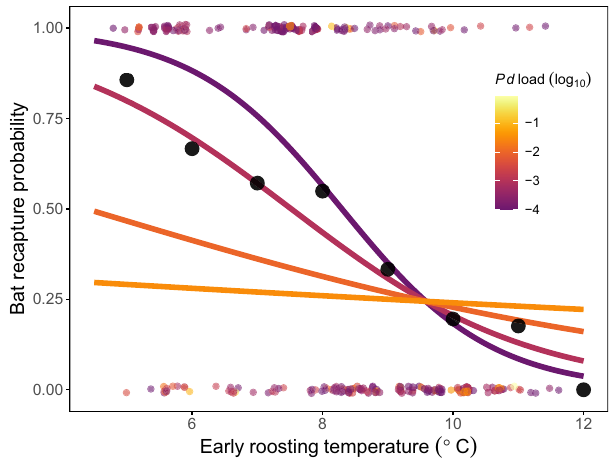
Fig. 4 Temperature and bat recapture probabilities. The probability that a banded little brown bat that was infected during early hibernation ( N = 259) was recaptured in late hibernation. Small points show the outcomes for individual bats (1 = recaptured, 0 = not recaptured) and black points show the proportion of recaptured bats for each temperature, binned by 1 °C intervals.